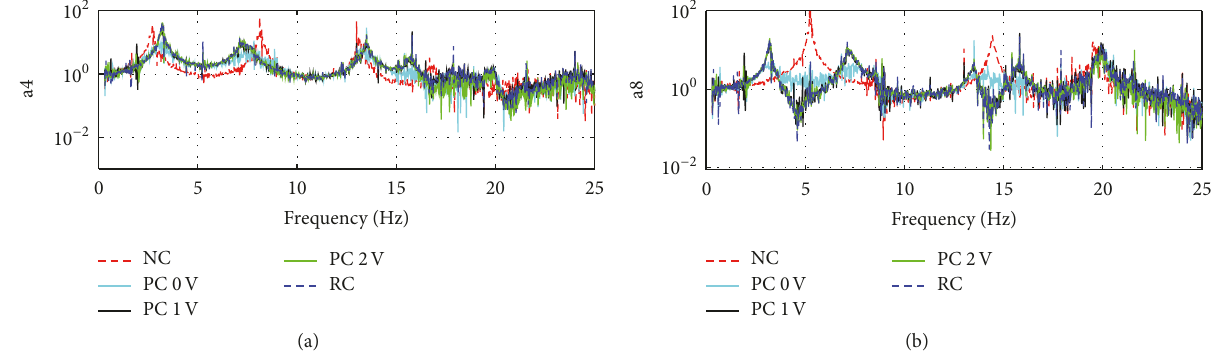
Figure 10: Experimental frequency response functions. Ground acceleration 𝑥 direction nonconnected (NC), rigid connected (RC), and passive connected (PC) 0, 1 and 2 V configurations, (a) sensor a4 and (b) sensor a8. White noise test PGA